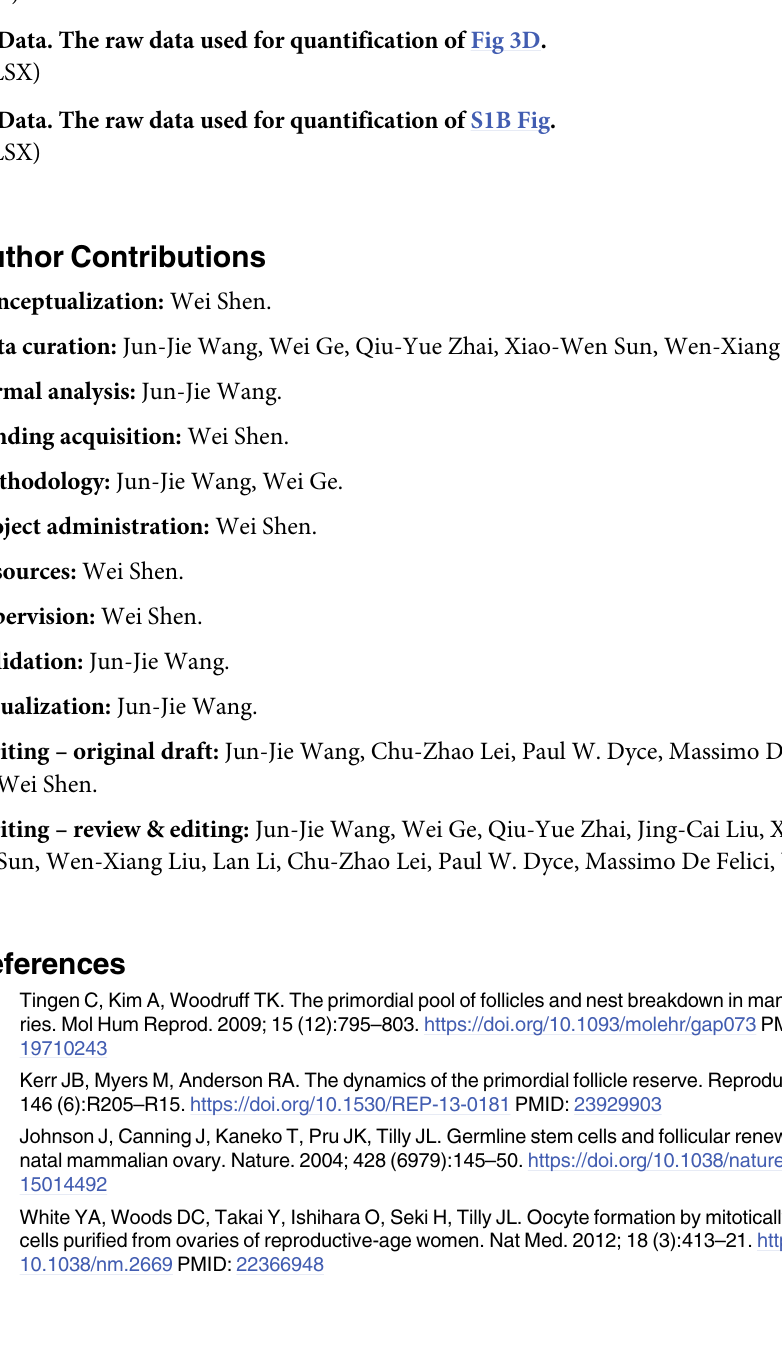
S9 Table. KEGG pathway of gene sets regard to differentiation of granulosa cells. KEGG, Kyoto Encyclopedia of Genes and Genomes. S10 Table. KEGG pathways of key genes regard to germ cell and granulosa cell fates. KEGG, Kyoto Encyclopedia of Genes and